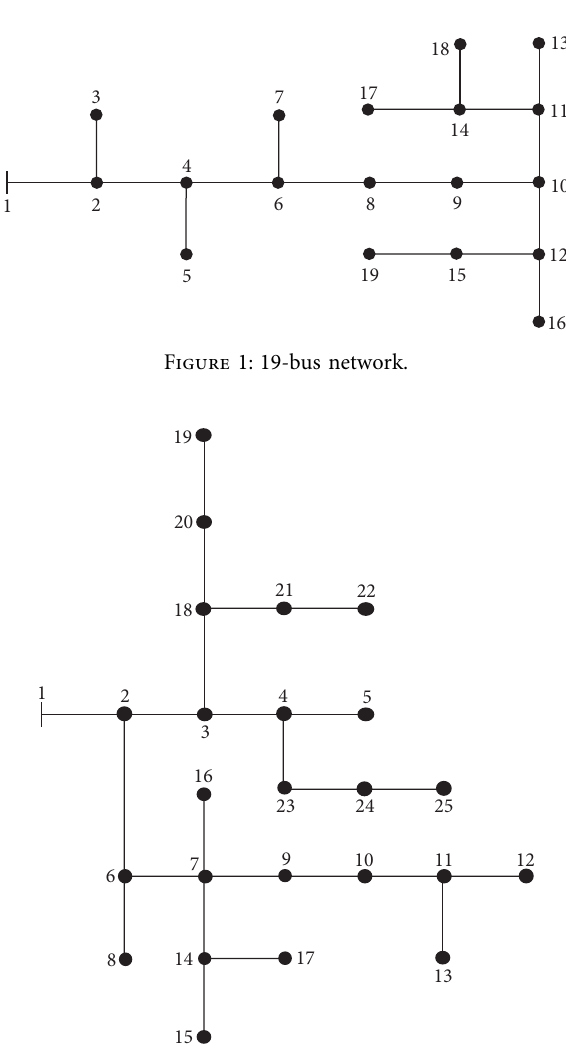
Figure 2: 25-bus